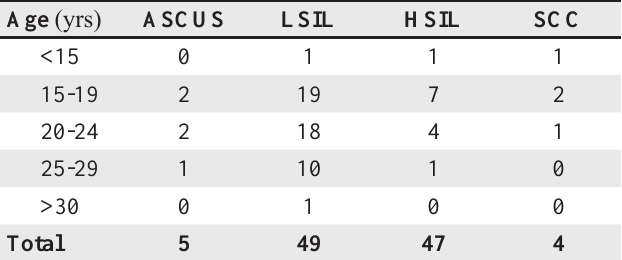
Table 3 : Age at first marriage of the patient with abnormal Pap